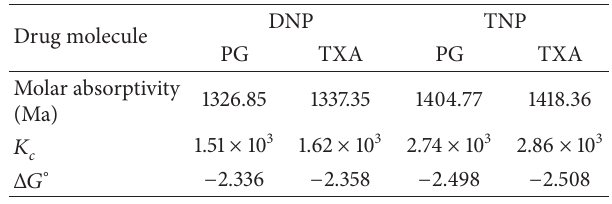
Table 1: Thermodynamic study.